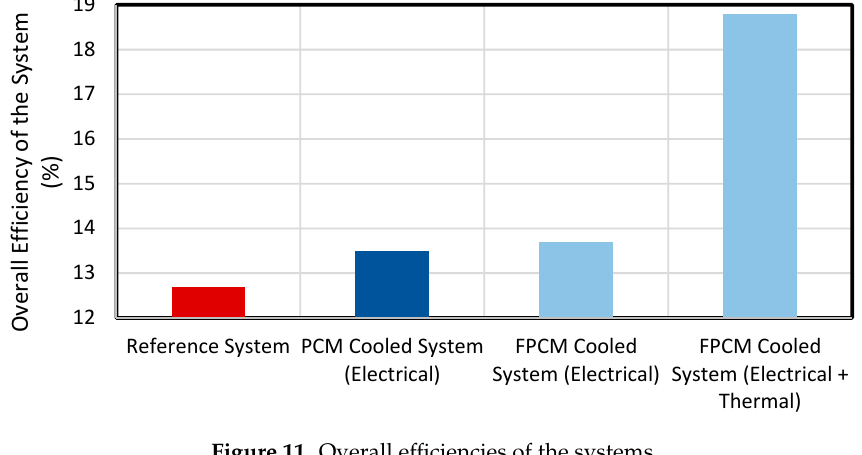
Figure 11. Overall efficiencies of the systems.